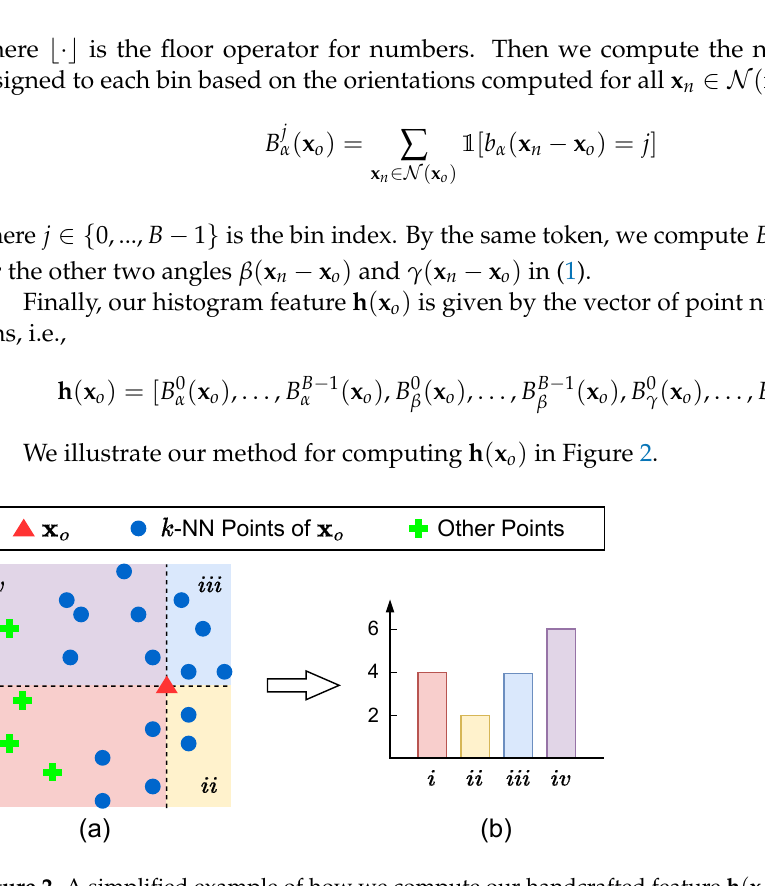
Figure 2. A simplified example of how we compute our handcrafted feature h ( x o ) for each point x o , we use an arbitrary one of the three 2D planes (i.e., xOy , yOz , and zOx ) in the example. ( a ) We first divide the neighbourhood of the point x o into four directional bins represented by the four quadrants i , ii , iii , and iv , respectively, then find the k -NN neighbour points of x o . We use k = 16 in this